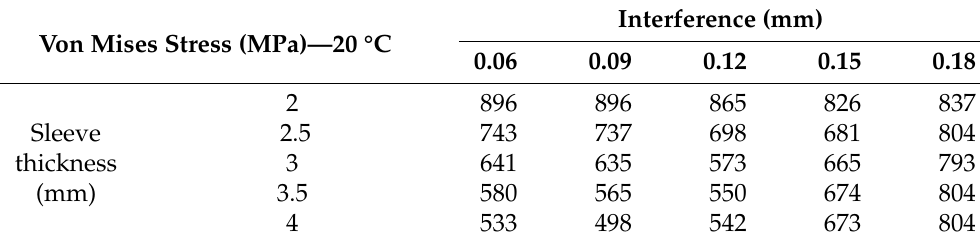
Table 4. The Von Mises stress results at different sleeve thickness and interference (20